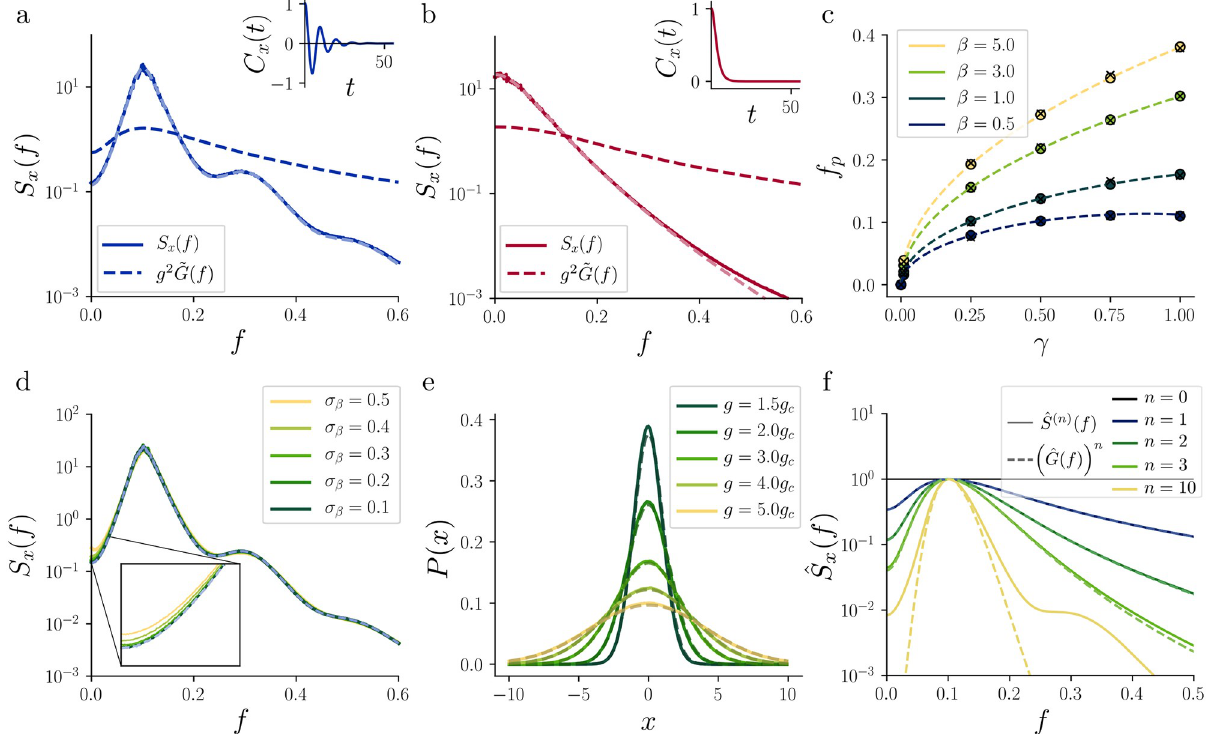
Fig 2. Self-consistent statistics in the chaotic regime. a: Resonant (narrow-band) chaos. Power spectral density obtained from mean-field theory (solid line) and microscopic simulations (light blue, dashed) for γ = 0.25, β = 1 and g = 2 g ( γ , β ). The dashed, dark blue line indicates the square c modulus of the linear response function ~ G ð f Þ for the same adaptation parameters. Inset: Normalized mean-field autocorrelation C ( τ ) for the same x parameters, plotted against the time lag in units of τ . b: Non-resonant (broad-band) chaotic regime. Curves and inset are the same as in a , but with γ = x 1, β = 0.1 and g = 2 g c ( γ , β ). c: Maximum-power frequency f p of the recurrent network plotted against γ , for different β . Crosses depict results obtained from microscopic simulations, circles show the semi-analytical prediction based on the iterative method and dashed lines shows the theory based on the single neuron response function. For γ = 0 all curves start at f p = 0. d: Power spectral density S x ( f ) for different levels of heterogeneity of the parameter β (solid lines), compared to the case without heterogeneity (dashed line). All the curves are almost superimposed, except at very low frequencies where small deviations are visible (inset). Parameters: γ = 0.25, � b ¼ 1 , g ¼ 2 g ð g ; � b Þ . e: Distributions P ( x ) of the activation x from microscopic simulation c ( N = 2000, solid lines) and theoretical prediction (dashed lines). The adaptation parameter were γ = 0.25 and β = 1. f: Normalized power spectral ð f Þ ≔ S ð f Þ = max ð f Þ (solid lines) at different iterations n , for the network with adaptation. For the first iterations, the powers of density ^ S S x x f x ^ G ð f Þ ≔ ~ G ð f Þ = max ~ G ð f Þ (dashed lines), provide a good approximations of the power spectrum width. The initial power spectral density is a constant f and the network parameters are the same as in panel a